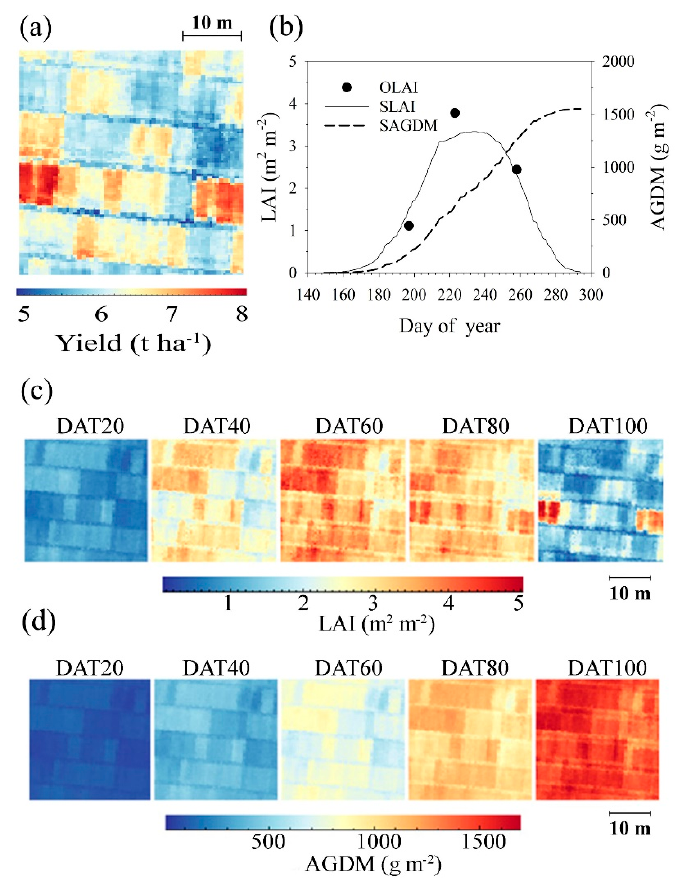
Figure 8. Simulated geospatial variation in paddy yield ( a ), simulated (S) and observed (O), temporal variations in leaf area index (LAI) and above ground dry mass (AGDM) ( b ), and spatiotemporal variations in LAI ( c ) and AGDM ( d ) at 20, 40, 60, 80, and 100 days after transplanting (DAT). The data were simulated using RapidEye satellite imageries with a 5-m ground resolution.